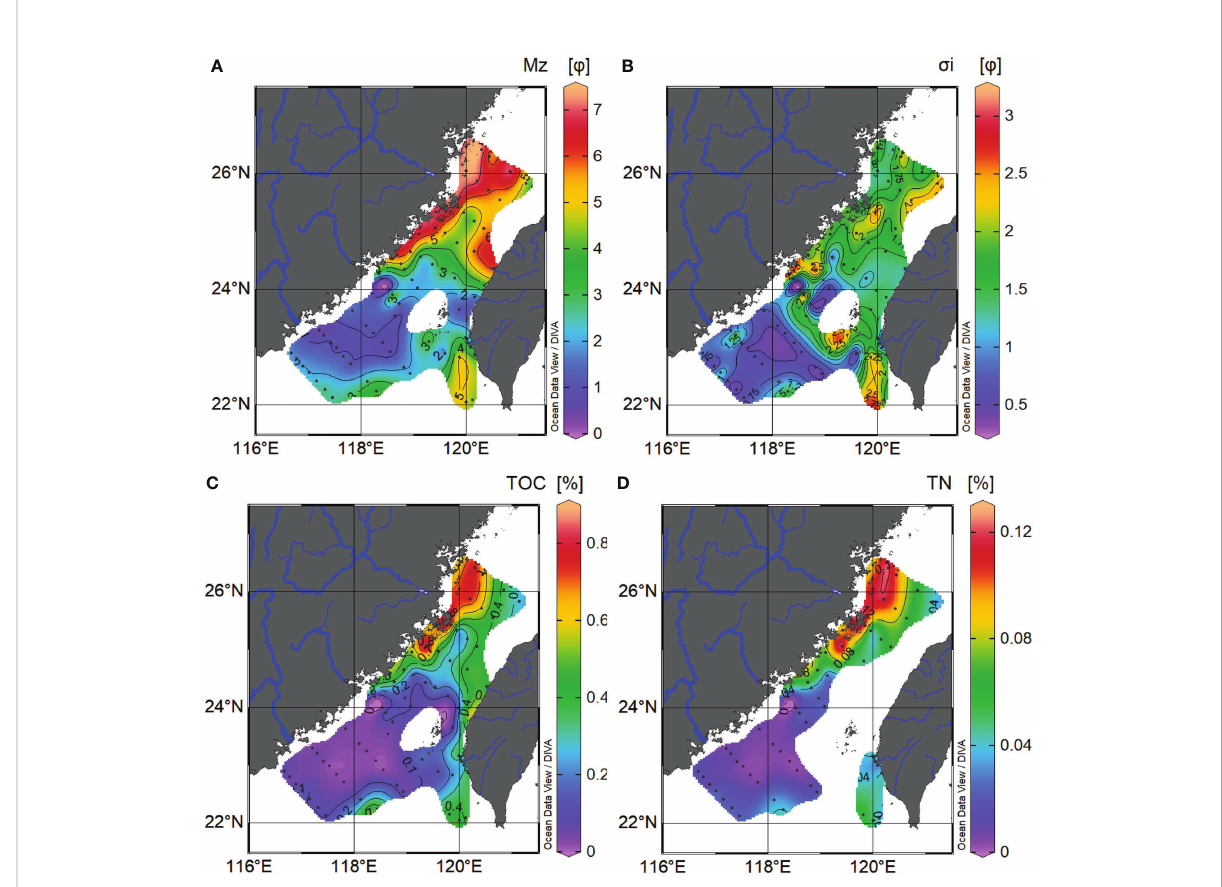
Figure 3. Figures 3A, B show the spatial pattern variations of mean grain size (Mz) and sorting coef fi cient ( s i ) in surface sediments with the range from 0.4 to 7.4 j and from 0.4 to 3.1 j , respectively. Well-sorted sand-sized sediments (Mz = 0 – 4 j , s j ) are widespread in the southern part of the study area i < 1 such as offshore of Guangdong, the TWB and the WQD, while poorly sorted mud (silt+clay, Mz = 5 z.bar; 8 j , s i > 1.5 j ) occupies areas of the northwest along the Min-Zhe mud belt stretching from the mouth of the Yangtze River to near the Dajia River ’ s mouth on the west coast of Taiwan. Surface sediments in the GYD, the middle of northern TS, and the southern Penghu Channel show a medium range of the mean grain size (Mz = 4 – 5 j ), suggesting typical silt